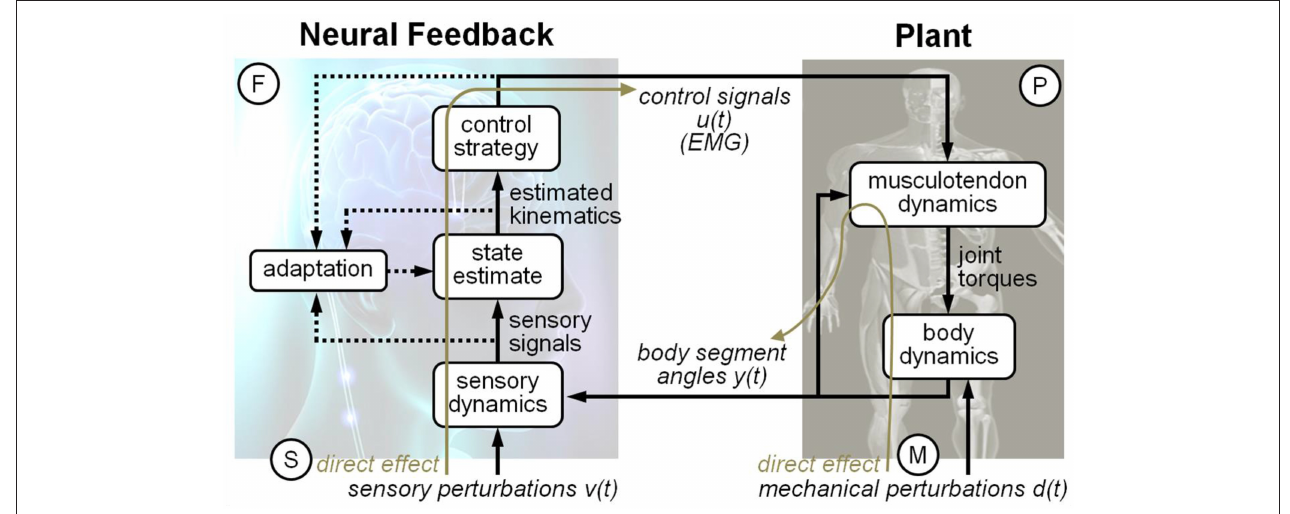
FIGURE 1 | Schematic diagram of the human postural control feedback loop. The human postural control feedback loop consists of three major components: feedback, plant, and direct effect.